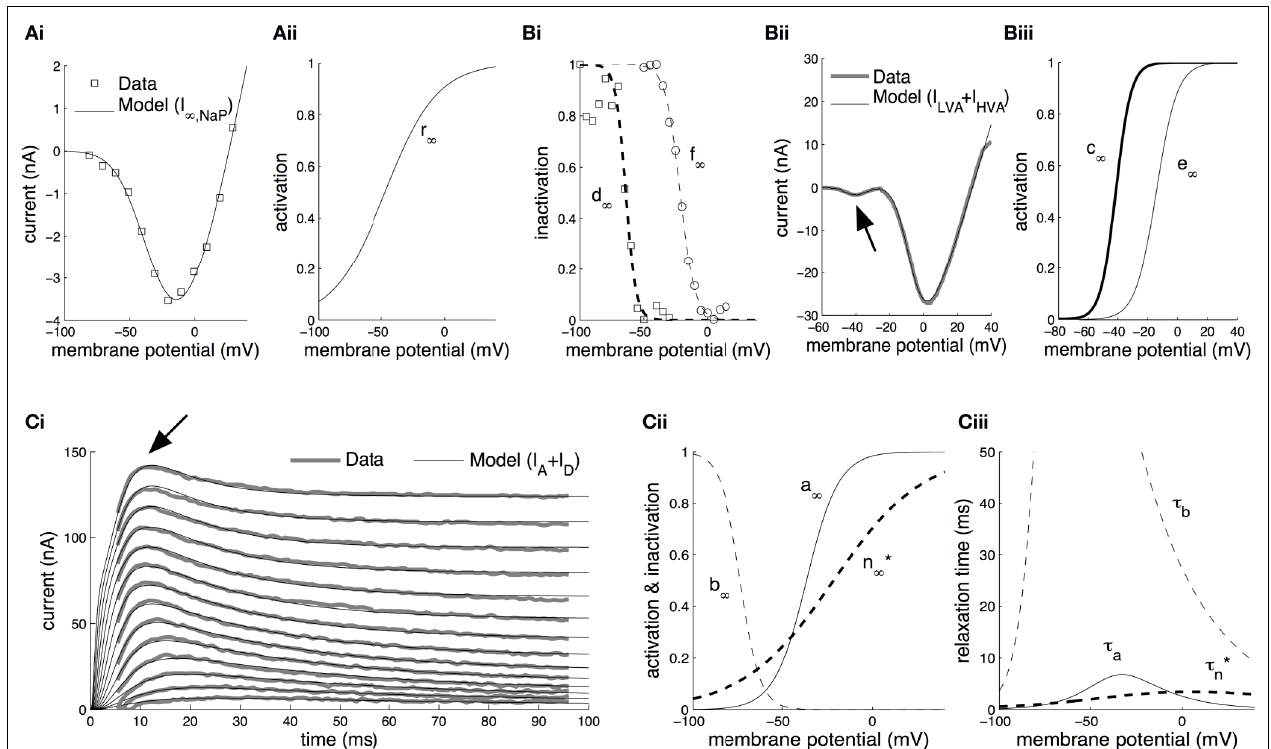
induced during a voltage-ramp protocol changing the membrane potential from FIGURE 1 | Parameter estimation from voltage-clamp data. (A) Estimation − 100 mV to + 30 mV over a time interval of 120 ms ( Bii ; Staras et al., 2002). The of the steady-state activation of the persistent sodium current. Persistent sodium currents at equilibrium, I ∞ arrow in Bii indicates the low-voltage-activated component corresponding to I , were measured at the end of 800 ms-long . ,NaP LVA voltage steps to membrane potentials in the range from − 90 to + 30 mV from a From the fi tted model, we derived the steady-state activation for I and I ( c ∞ LVA HVA holding potential of − 110 mV ( Ai , open squares; Nikitin et al., 2006). The model and e ∞ , respectively) as sigmoid functions of the membrane potential (Biii) . (C) for I ∞ Estimation of the activation and inactivation kinetics for the transient ( I (Eq. S11 in section Materials and Methods in Supplementary Material) ) and ,NaP A was fi tted against this data ( Ai , solid line) permitting the estimation of the delayed-rectifi er ( I ) potassium currents. The model for the total potassium D steady-state activation of the current, r ∞ , as a sigmoid function of the membrane current under voltage-clamp (Eq. S13–S16 in Supplementary Material) was fi tted to current traces induced during 100 ms-long voltage steps from a holding potential (Aii) . (B) Estimation of the steady-state activation and steady-state membrane potential of − 90 mV to steps from − 20 to + 35 mV ( Ci ; Staras et al., inactivation of the low-voltage-activated and high-voltage-activated calcium currents. The steady-state inactivation for I 2002) using the full trace method (Willms et al., 1999). The arrow in Ci indicates , d ∞ , was computed by fi tting a LVA sigmoid curve to normalized peak currents recorded during voltage steps to the early transient component corresponding to I . The fi tted model permitted A − 50 mV from holding membrane potentials between − 100 mV and − 30 mV (Bi , the estimation of the steady-state activation, a ∞ , and inactivation, b ∞ , for the open squares; Staras et al., 2002). Similarly, for the steady-state inactivation of transient potassium current I , and the steady-state activation, n ∞ *, for the A I delayed rectifi er as illustrated in Cii . The corresponding relaxation times, τ , f ∞ , we fi tted a sigmoid curve to normalized peak currents recorded during , τ HVA a b ∗ , were also derived from the fi tted model ( Ciii ). The estimated kinetic voltage steps to 0 mV from holding membrane potentials between − 60 mV and and τ n + 15 mV (Bi , open circles; Staras et al., 2002). Subsequently, the model in Eq. parameters for I are marked with an asterisk, because they are further modifi ed D S12 in Supplementary Material was fi tted against the total calcium current and receive their fi nal values based on current clamp